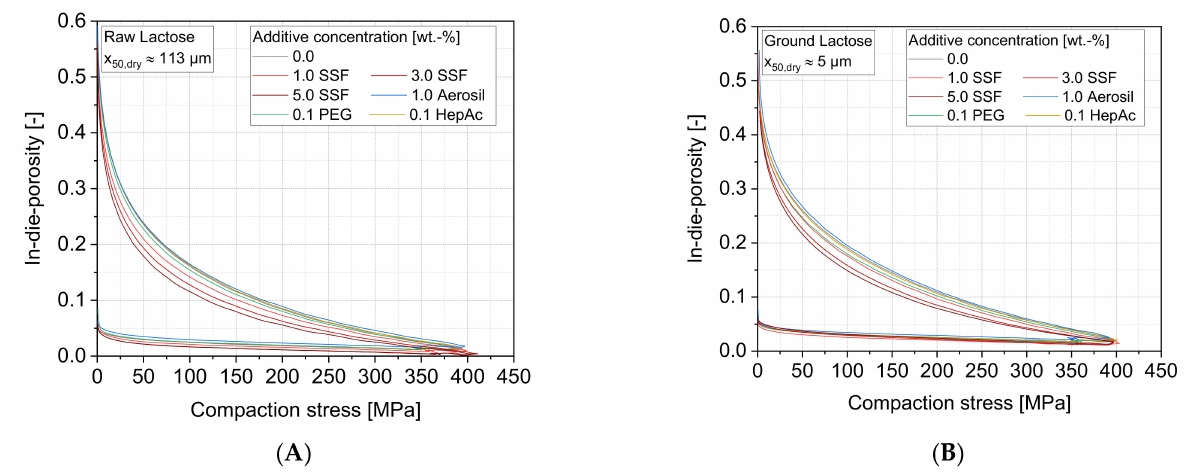
Figure 11. In-dye porosity as a function of the compaction stress for different additives: ( A ) raw lactose and ( B ) ground lactose. n = 1